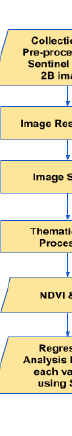
Figure 3. Flowchart for the ESA-SNAP Sentinel-2 image processing and Biophysical Parameter